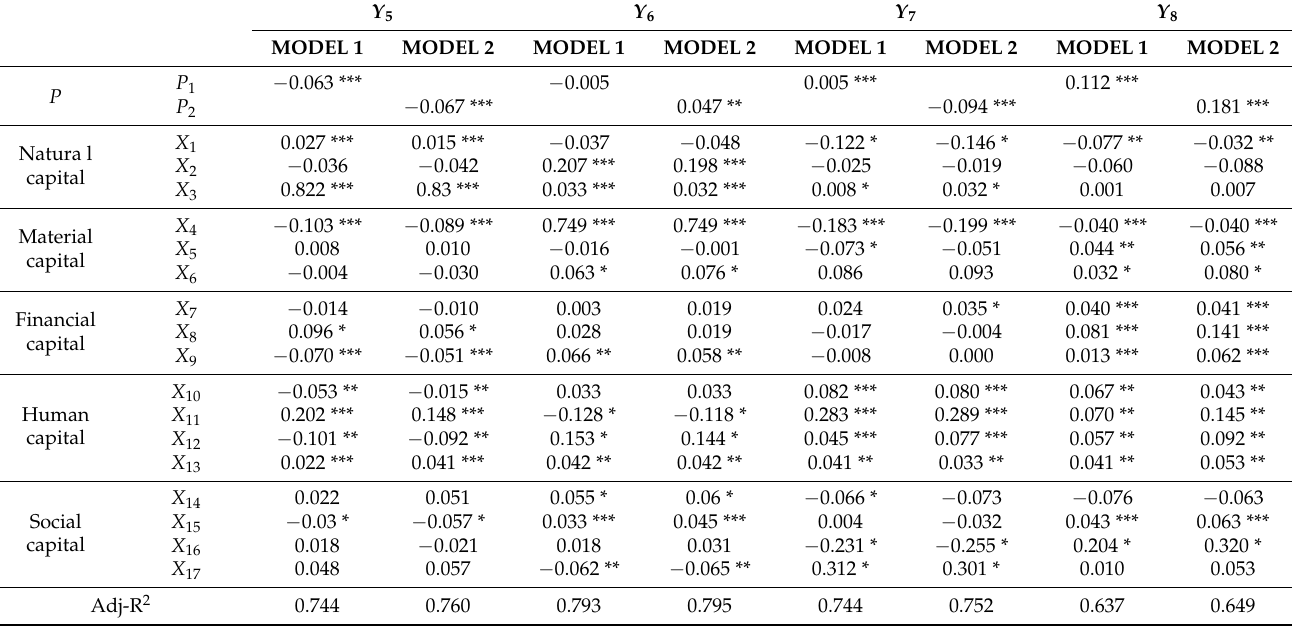
Table 7. Regression results of impact of ecological compensation on income from livelihood